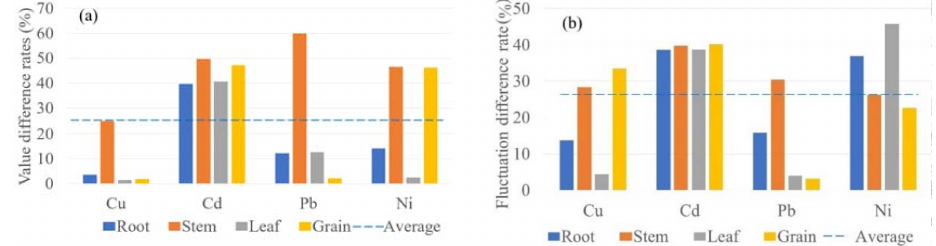
Figure 7. ( a ) Value difference rates (V DR ) and ( b ) Fluctuation difference rates (F DR ) of the modeling